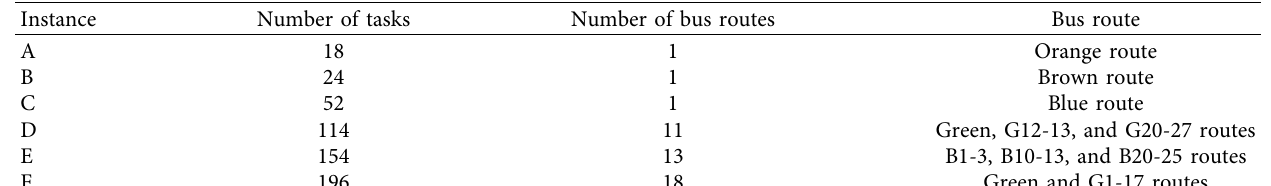
Table 1: Experiment data.